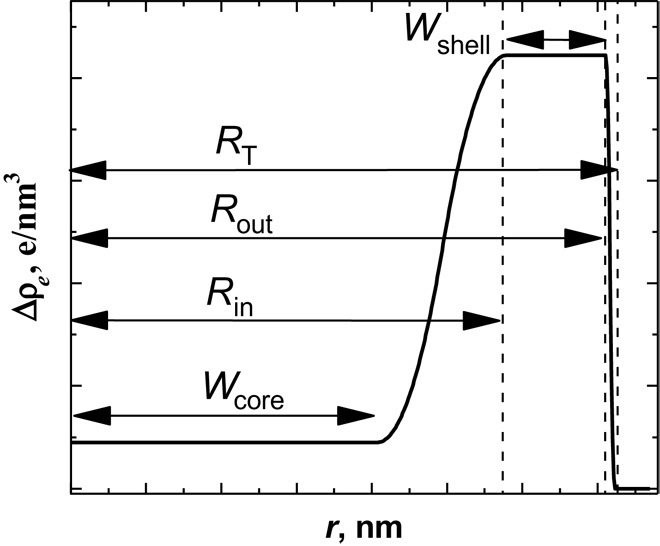
Scheme of a radial excess electron density profile for PNIPAM microgels in MeOH/H2O mixtures.The parameters characterizing the radial excess electron density in this form factor model are the core thickness Wcore, the shell thickness Wshell, the inner radius Rin, the outer radius Rout, and the total radius RT.